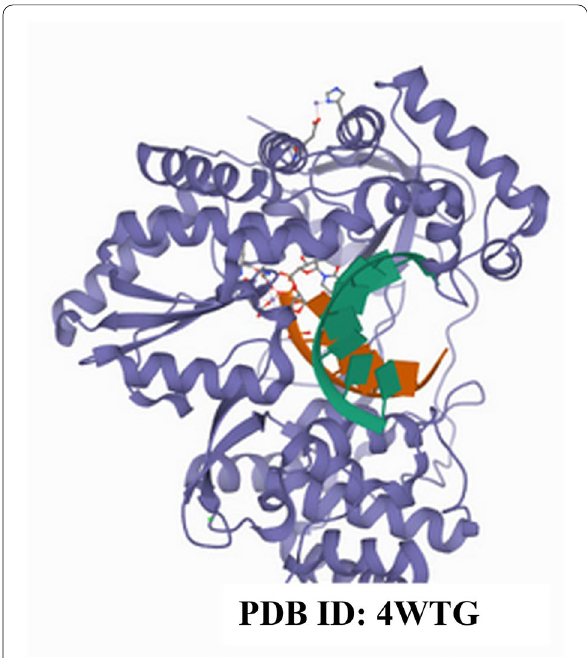
Fig. 2 Structural skeleton of compound 1 showing R position as a point of